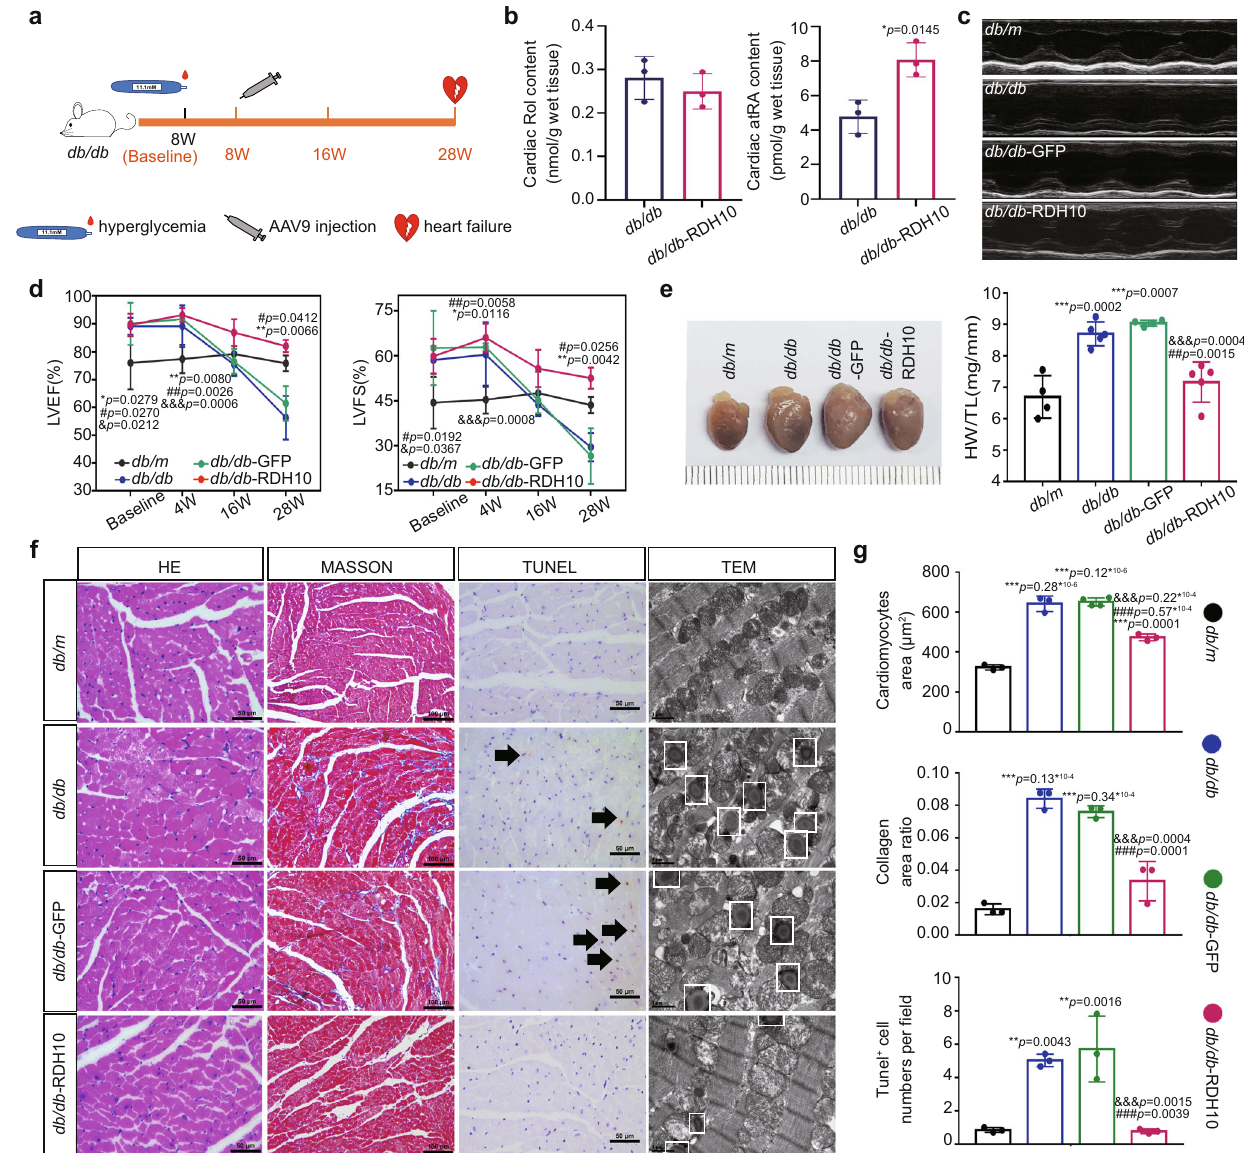
Fig. 5 | Cardiac retinol metabolic status,structure, and functionin T2DMmice injectedwithviaadeno-associatedvirus9(AAV9)-RDH10(nmeansbiologically independent animals). a Schematic diagram of AAV9-RDH10 injection. b Cardiac Rol and atRA levels, n =3, * vs db/db . c Echocardiography. d LVEF and LVFS, n (baseline)=5 ( db/m ),5 ( db/db ), 4 ( db/db -GFP) and 5 ( db/db -RDH10); n (4w)=5 ( db/ m ), 5 ( db/db ), 4 ( db/db -GFP) and 5 ( db/db -RDH10); n (16w)=3 ( db/m ), 5 ( db/db ), 4 ( db/db -GFP)and3( db/db -RDH10); n (28w)=3( db/m ),3( db/db ),3( db/db -GFP)and3 ( db/db -RDH10); * vs db/db ; # vs db/db -GFP; & vs db/db -RDH10. e Heart image and